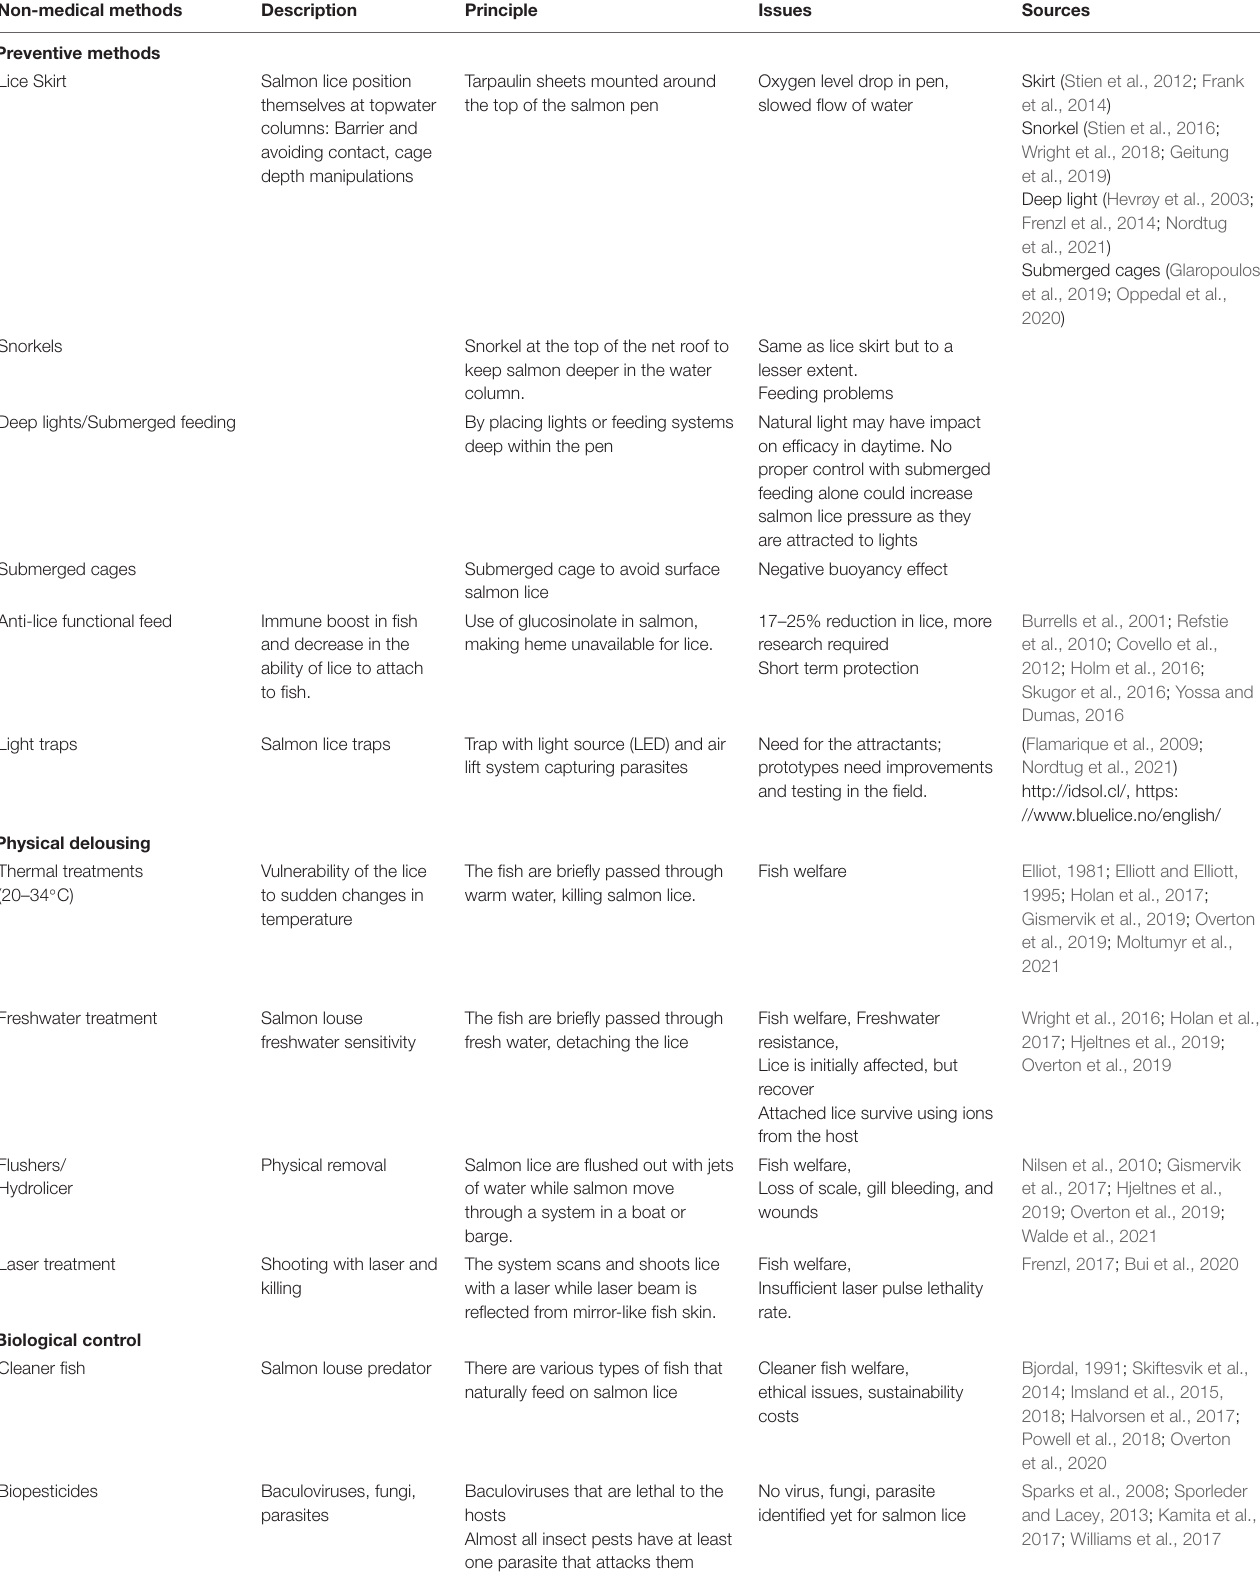
TABLE 3 | Overview of non-medical and biological control strategies for salmon lice